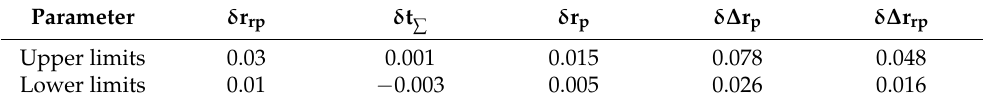
Table 1. Dimensions of parts are in millimeters. Table 1. Design upper and lower limits of parameter error of main parts